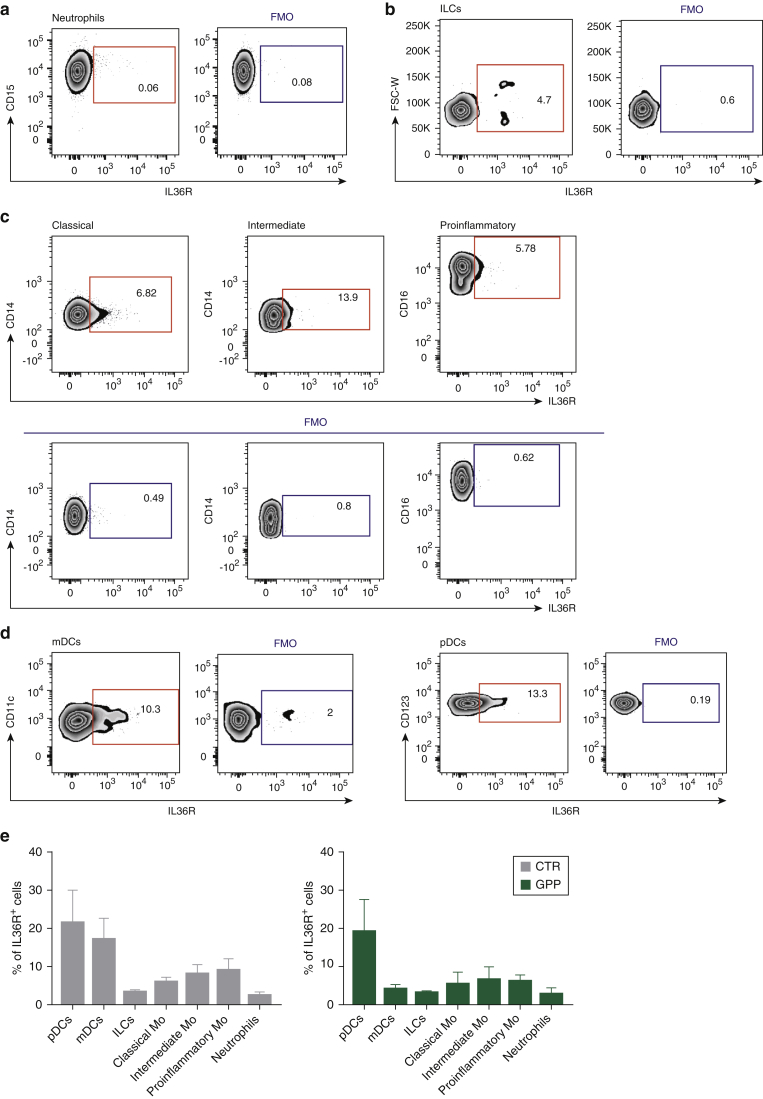
The IL-36 receptor is preferentially expressed by plasmacytoid dendritic cell s. (a–e) Representative flow cytometry plots showing IL36R surface expression compared with fluorescence minus one control. (a) neutrophils (gated as CD14+, CD15+, CD16+ cells); (b) innate lymphoid cells (lineage- [CD3-, CD4-, CD19-, CD20-, CD56-], CD127+); (c) monocytes (CD3-, CD20-, CD19-, CD56-) separated into classical (CD16-, CD14high), intermediate (CD16+, CD14+), and pro-inflammatory (CD16high, CD14-) populations; (d) pDCs (lineage-, HLA-DR+, CD123+, CD11c-) and mDCs (lineage-, HLA-DR+, CD123-, CD11c+). (e) Histogram showing the percentage IL36R+ cells in each leukocyte population. Data were obtained in at least three GPP cases and three sex-matched controls. Results are presented as mean ± SEM. No significant differences were observed between GPP cases and healthy donors. FMO, fluorescence minus 1; IL36R, IL-36 receptor; GPP, generalized pustular psoriasis; mDC, myeloid dendritic cell; Mo, monocytes; pDC, plasmacytoid dendritic cell; SEM, standard error of the mean.